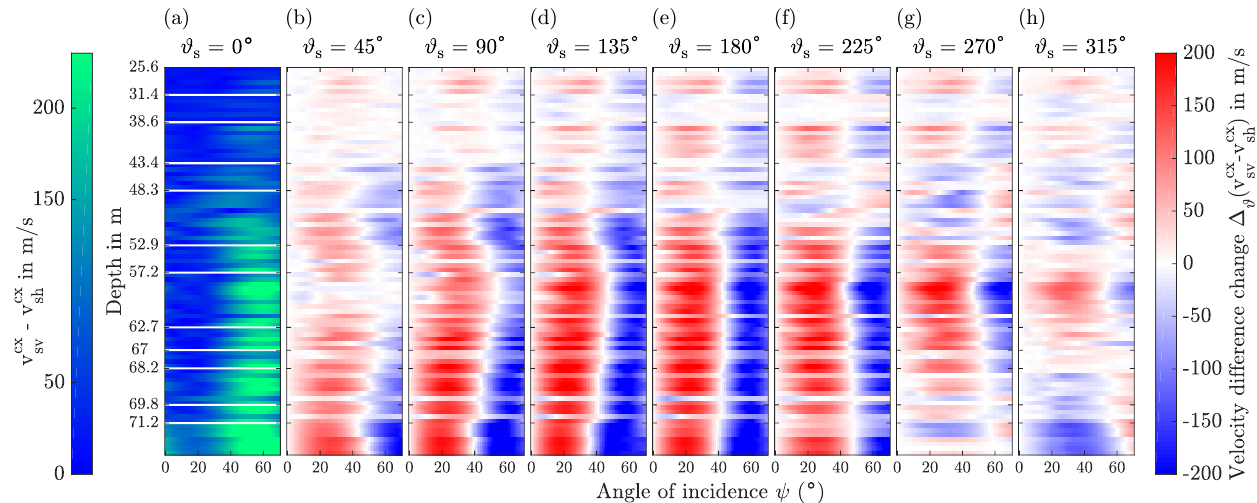
Figure 9. (a) Difference in KCC seismic velocities between SH- and SV-wave as calculated with the cx framework for incidence angles up to 70 ◦ . (b–h) Change in the S-wave velocity difference for different seismic plane azimuth angles ϑ s . The extreme values ( (cid:49) ϑ ( v cx sv − v cx [− 269 , 238 ] ms − 1 ) lie in the saturated range of the colour scale, providing a better visual contrast (compare Table 2). Note the breaks in the depth axis where noted depth values refer to the top of the downward-extending depth